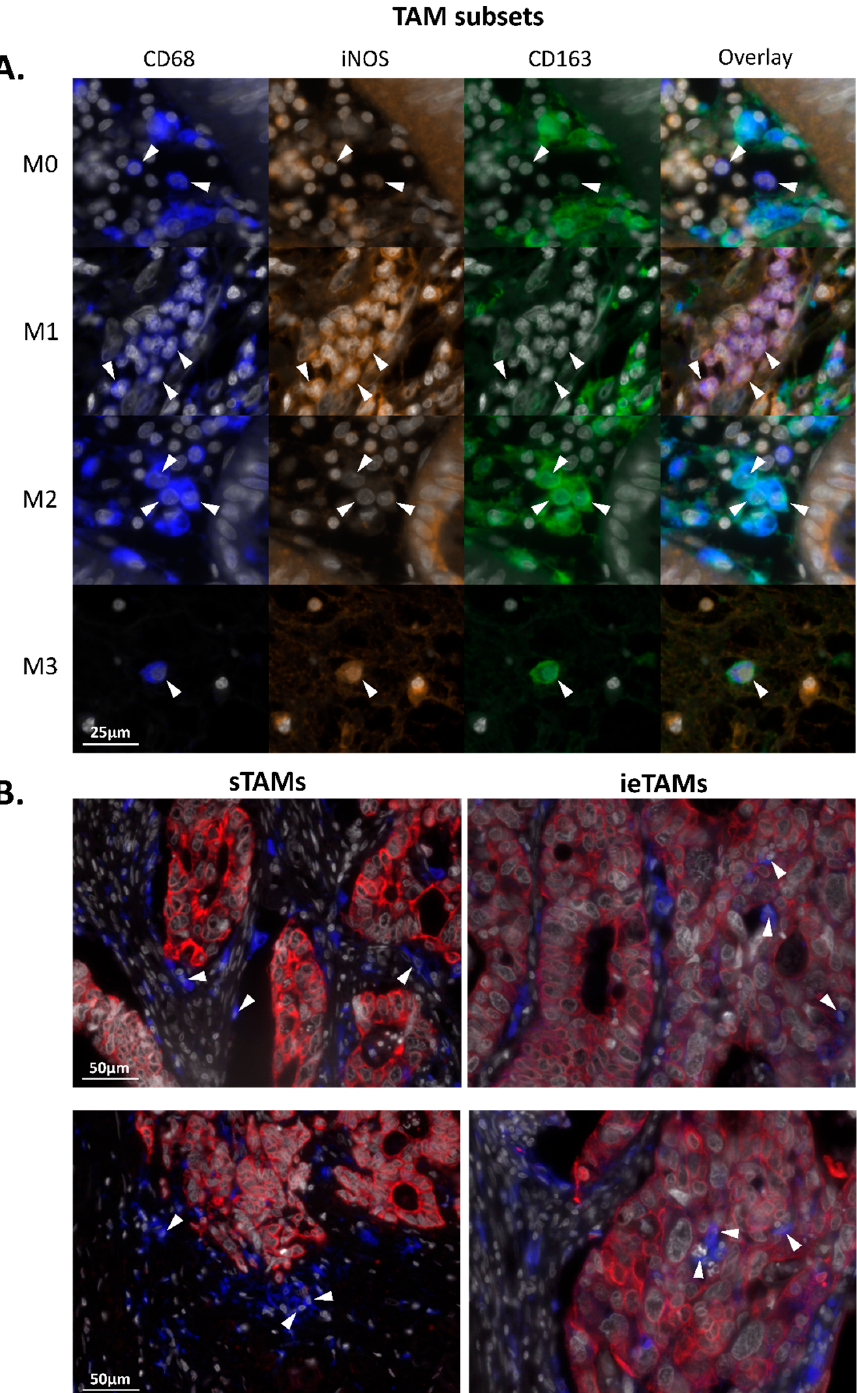
Figure 4. TAM subsets in primary colorectal tumors as visualized by multiplex immunofluorescence. ( A ) Image of M0 (CD68 + iNOS − CD163 − ), M1 (CD68 + iNOS + CD163 − ), M2 (CD68 + iNOS − CD163 + ) and M3 (CD68 + iNOS + CD163 + ) TAMs. ( B ) Representative images of colorectal tumors with high numbers of stromal TAMs (sTAMs) and intraepithelial TAMs (ieTAMs) (white: DAPI; red: cytokeratin + tumor epithelium; blue: CD68 + TAMs). The white arrows indicate examples of TAMs with indicated phenotypes ( A ) or localizations ( B ). Abbreviations: CRC (colorectal cancer), iNOS (inducible nitric oxide synthase), ieTAM (intraepithelial TAM), sTAM (stromal TAM), TAM (tumor-associated macrophage).